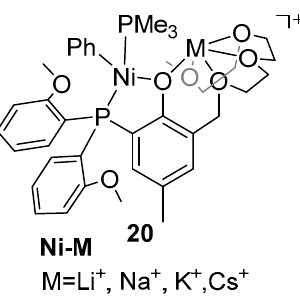
Figure 17. Cation-tunable heterobimetallic nickel-alkali catalyst 20 bearing phenoxyphosphine- PEG.